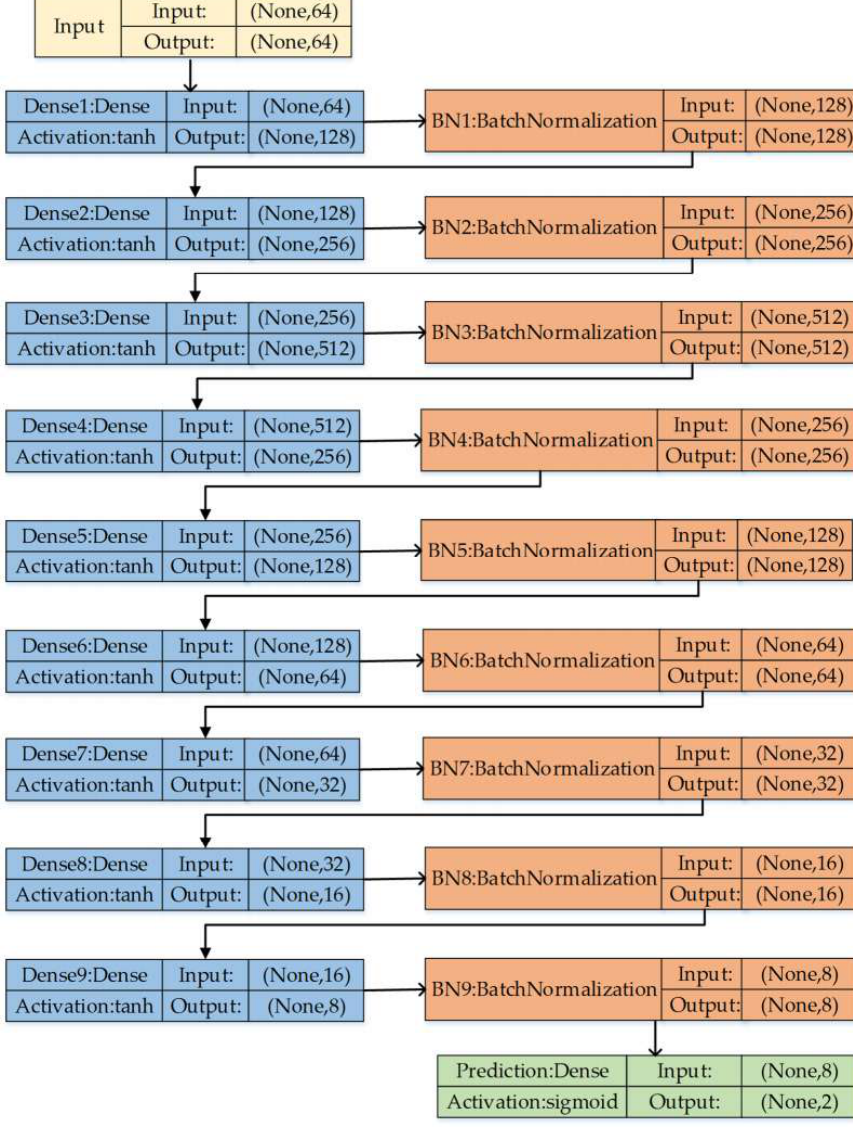
Figure 6. Regression model network structure based on MLP.